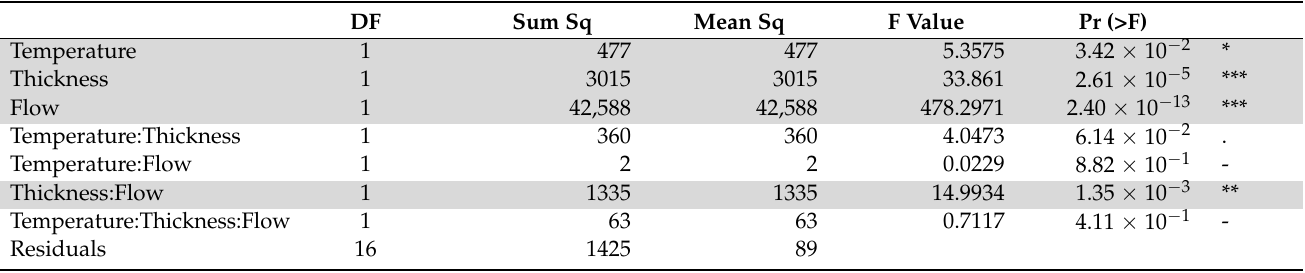
Table 14. Statistical significance of the effects of the printing parameters and their interactions on samples flexural yield strength.